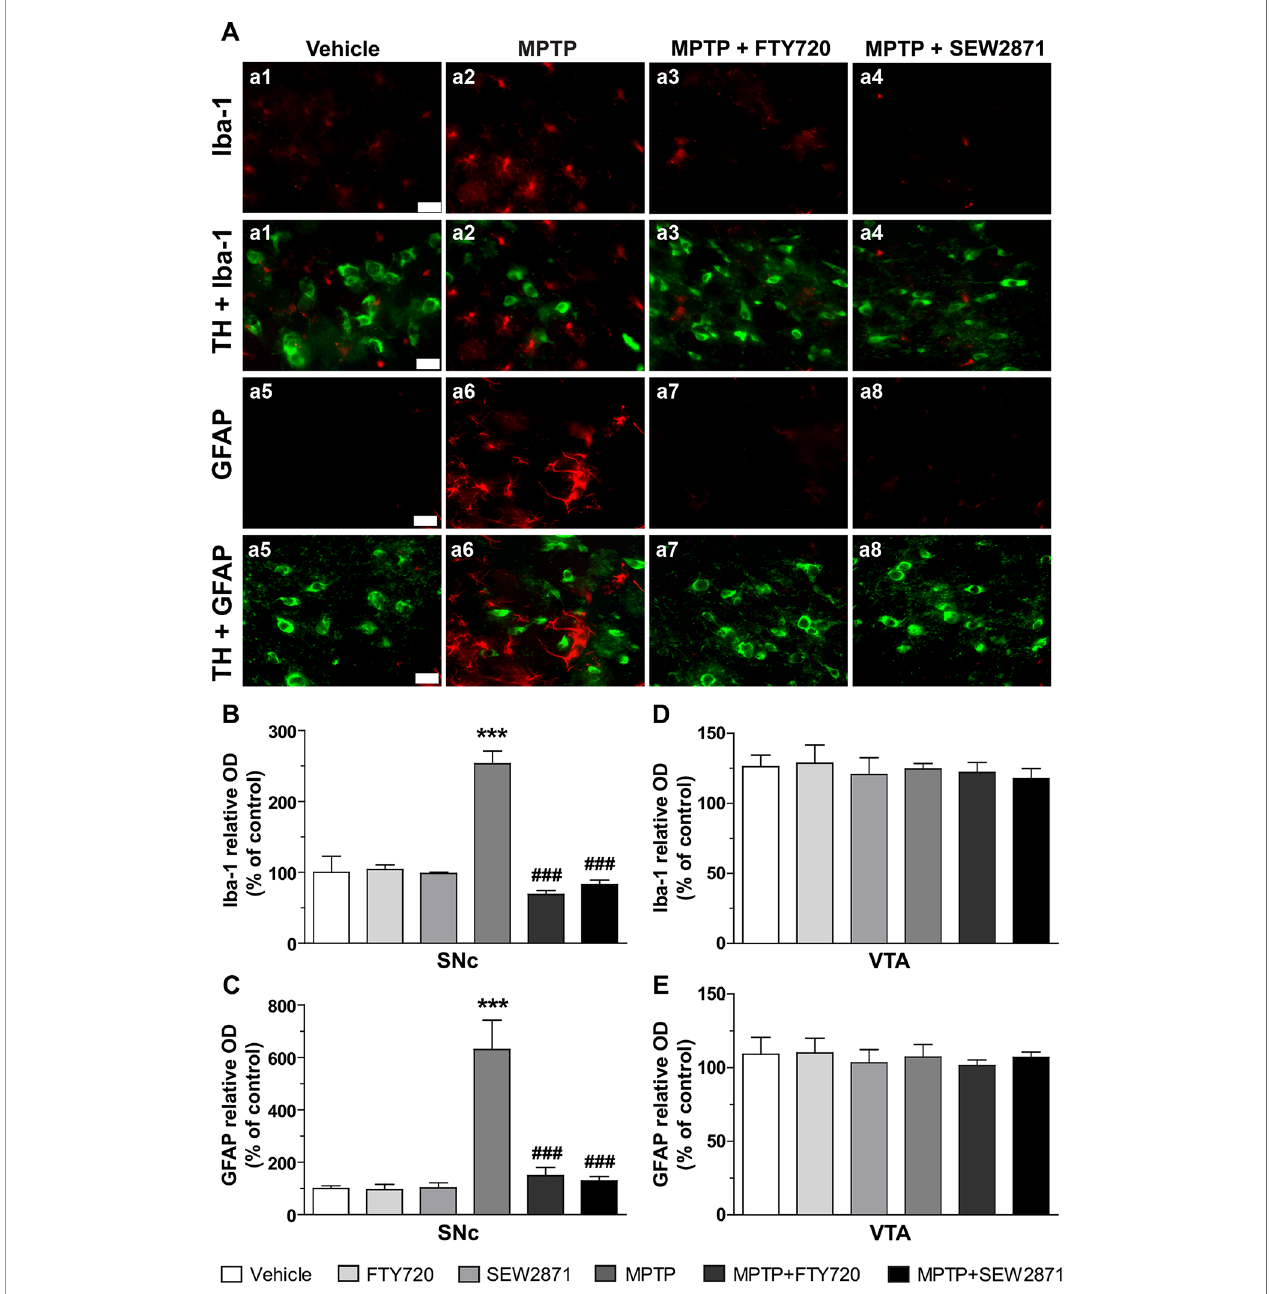
FIGURE 4 | Signs of astrogliosis and microgliosis induced by 1-methyl-4-phenyl-1,2,3,6-tetrahydropyridine (MPTP) are prevented by S1P1R modulators. (A) Representative examples of Iba-1 immunoreactive microglia (panel a1 to a4; red color), GFAP-positive astrocytes (panel a5 to a8; red color) and TH-positive neurons (panel a1 to a8; green color) using epi fl uorescence microscope (40X objective) in the mouse subtantia nigra pars reticulate (SNr; − 3.16 mm from the Bregma). Bar equals 50 µm. Fluorescence intensity of Iba-1 and GFAP were measured in the SNc (B, D) as well as in the ventral tegmental area (VTA) (C, E) . The data represent the mean of Iba-1 and GFAP relative optical density (expressed as a percentage of control values) ± S.E.M., n = 3 – 5 mice/group. *** p < 0.001 vs . vehicle + saline; ### p < 0.001 vs . vehicle +